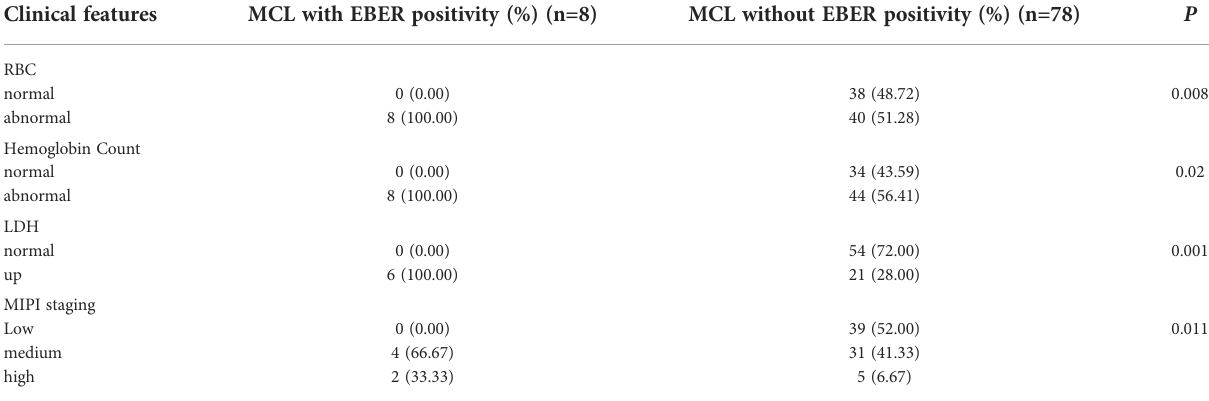
TABLE 1 Comparison of clinical characteristics between patients with and without EBER